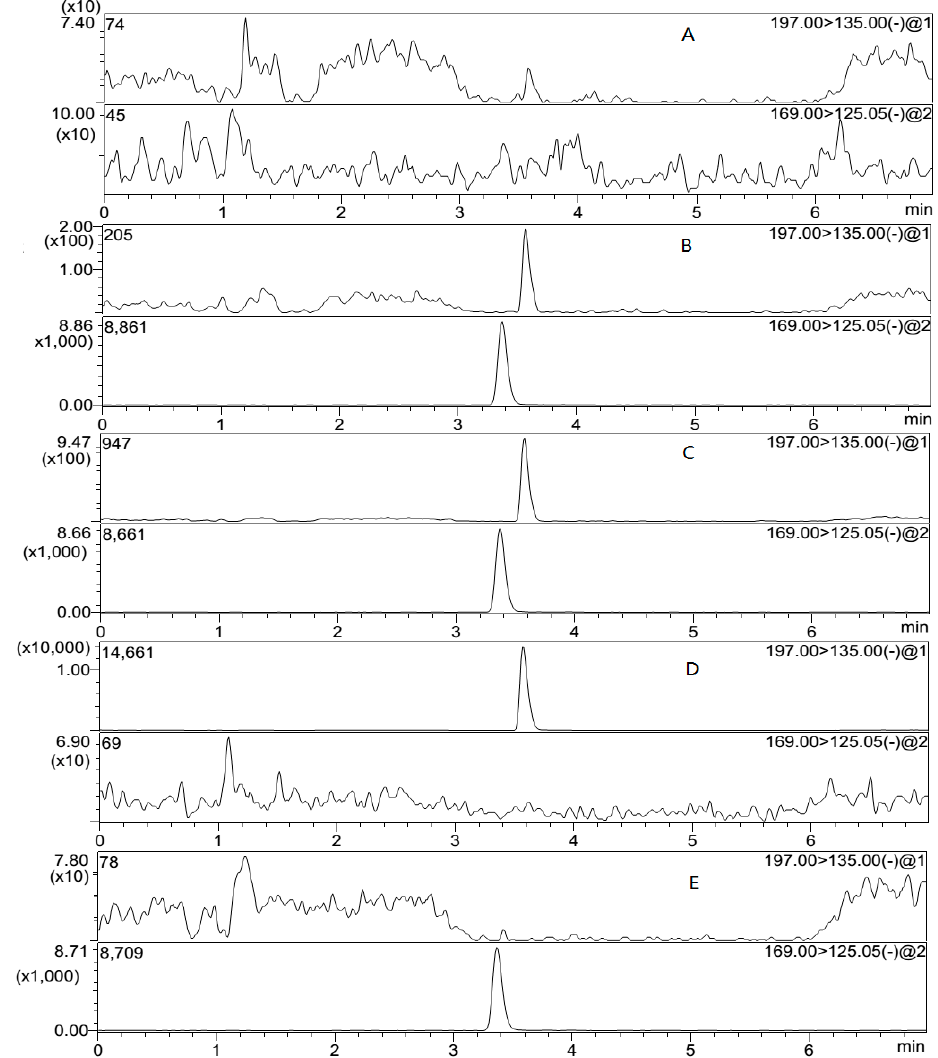
Figure 3. Representative MRM chromatograms of sodium danshensu and IS in beagle dog plasma samples. ( A ) A blank plasma sample; ( B ) a blank plasma sample spiked with sodium danshensu (10 ng/mL) and IS (25 ng/mL); ( C ) a plasma sample from a beagle dog 1.5 h after intravenous administration of sodium danshensu at a dose of 10 mg/kg. The assayed concentration of sodium (1000 ng/mL); ( E ) blank plasma spiked with IS only (25